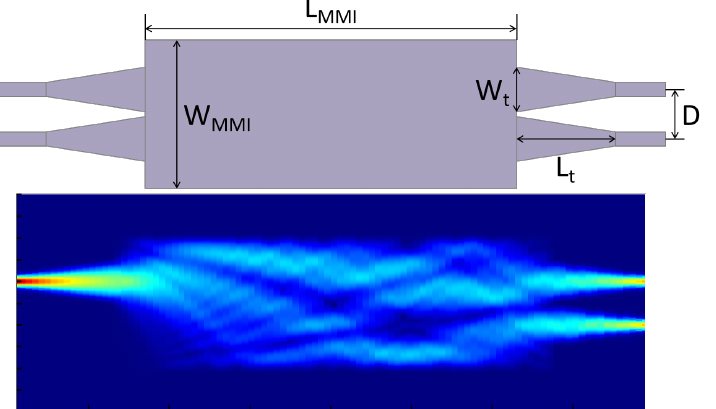
Figure 2. Schematic diagram of 2 × 2 MMI and the simulation result of mode field distribution.